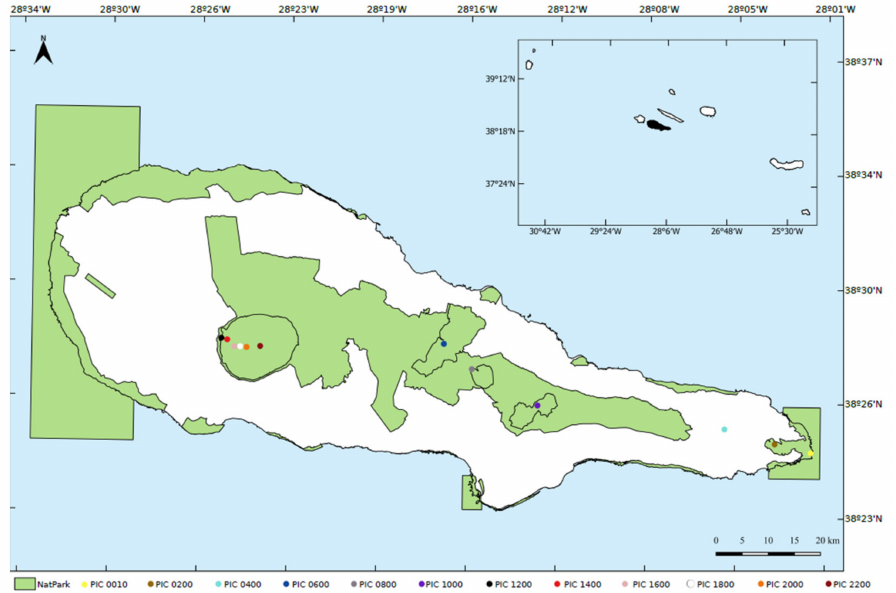
Figure 1. Location of Pico Island in the Azores archipelago (inset, upper right), and the natural park (in green). Dots show the location of the 12 sampled sites, from Manhenha (10 m a.s.l.) to Pico Mountain (2200 m a.s.l.), with a 200 m elevational step (September